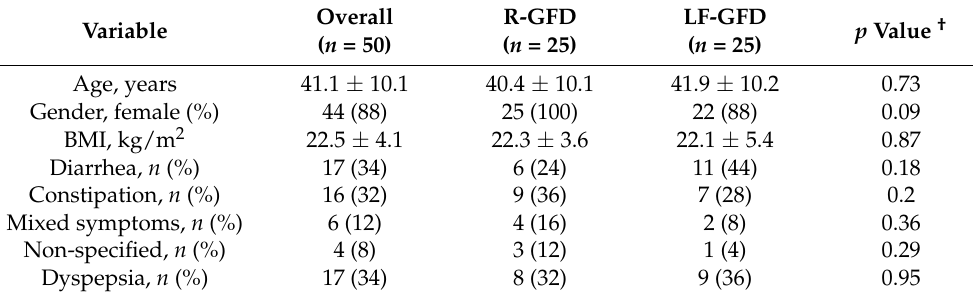
Table 2. Background and gastrointestinal symptoms at baseline 1